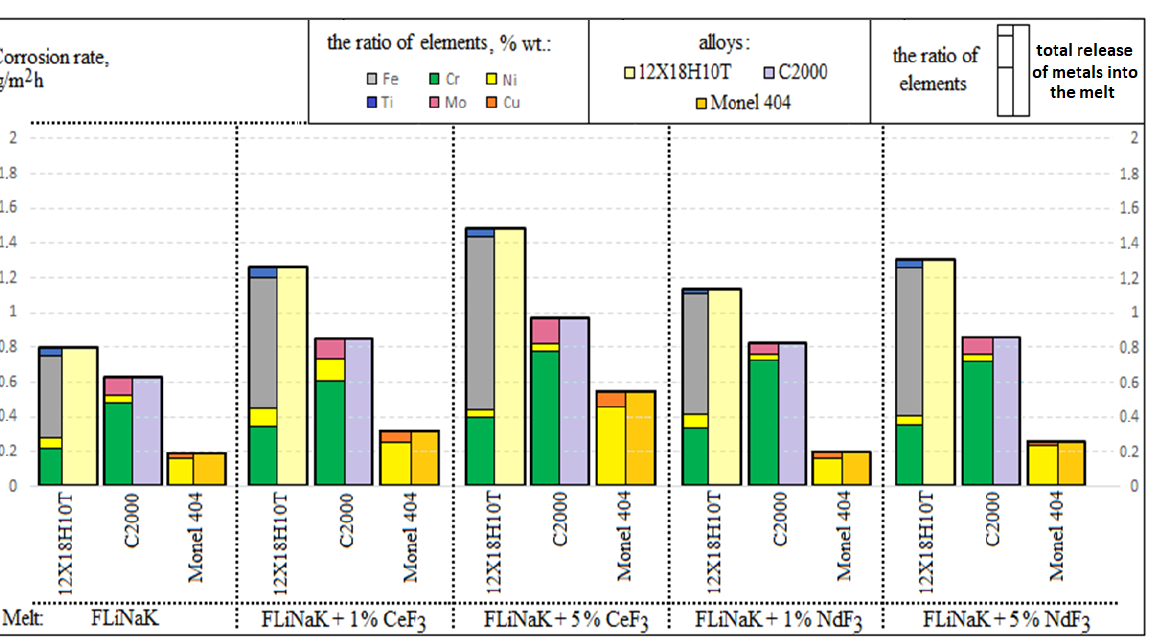
Table 2. Corrosion rate of the studied materials with an experiment time of 100 h.